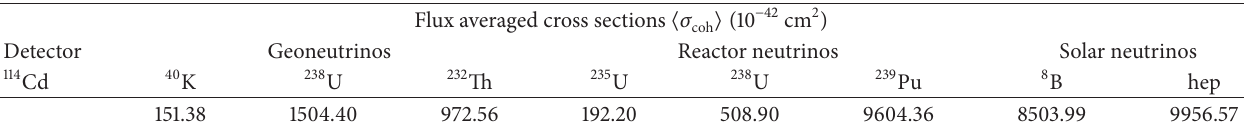
⟩ (in units 10 −40 cm 2 ) for 114 Cd isotope obtained in the case of neutrino energy spectra Table 3: Flux averaged coherent cross sections ⟨𝜎 coh coming from two neutrino sources: (i) geoneutrinos, (ii) reactor neutrinos, and (iii) solar neutrinos.